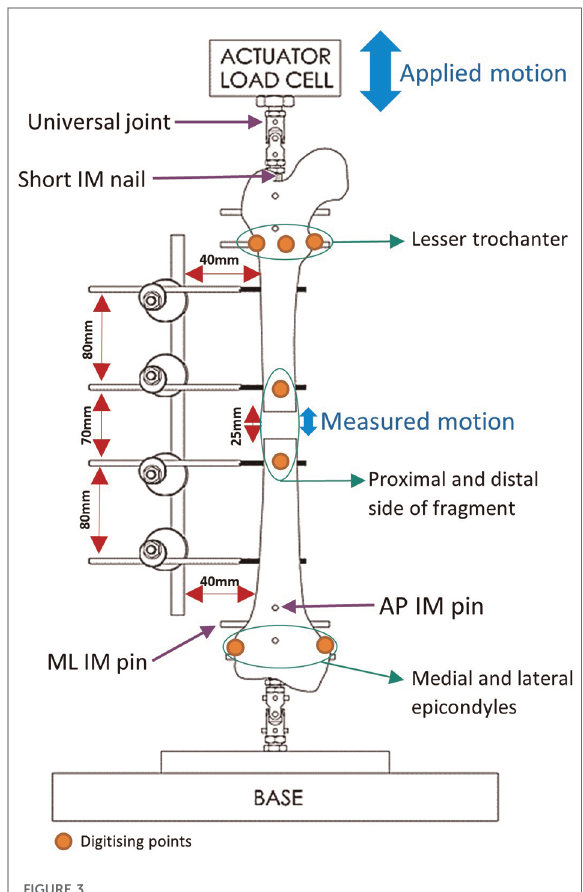
FIGURE 3 A schematic of the testing